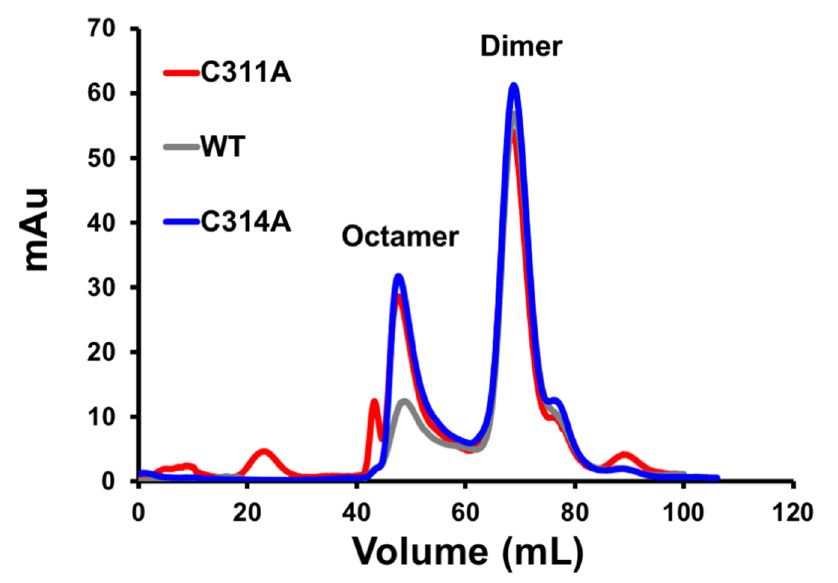
Figure 6. Dimer and octamer assessment of VP40 and single cysteine mutations in vitro. Size exclusion chromatogram trace of WT, C311A, and C314A purified VP40 protein shows similar formation of the dimer in solution compared to WT (only dimers used for lipid-binding assays). C311A and C314A both displayed an increased propensity towards the octamer form compared to WT VP40. The double mutant, C311A/C314A is not shown but demonstrated similar dimer and octamer peaks analogous to the single mutants.